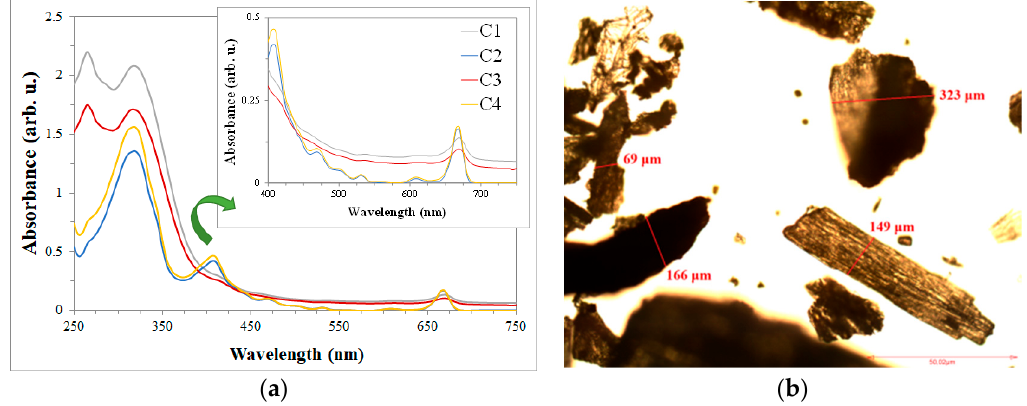
Figure 1. UV–VIS spectra and optical microscopy image of chamomile ( Matricariae flos